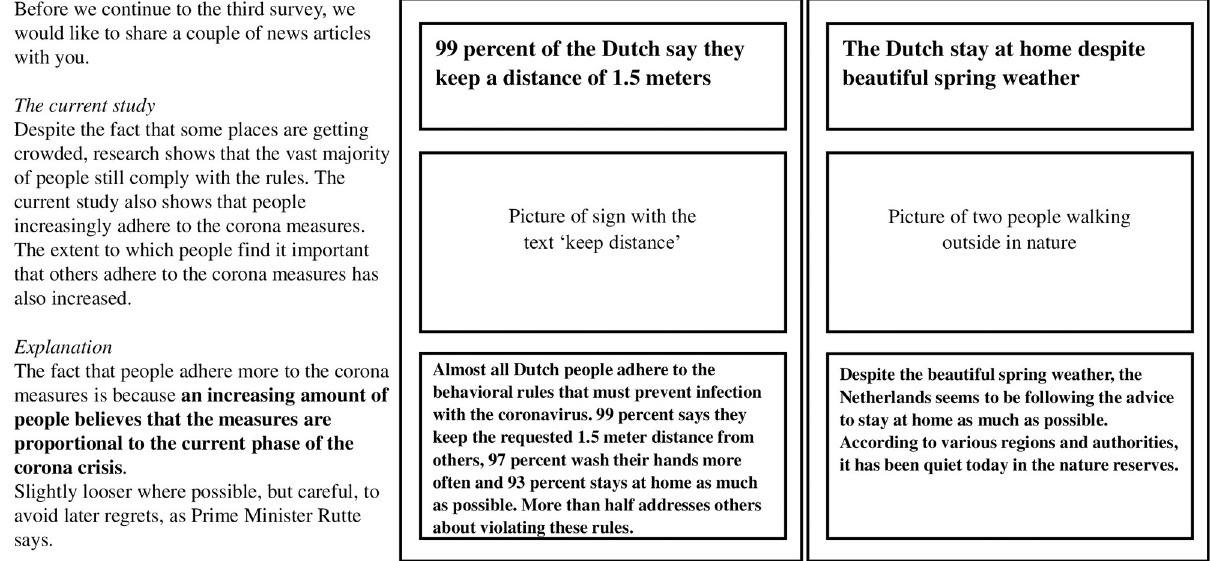
Fig 2. Example of intervention for ‘Social Norm high’ condition. News articles are replaced due to copyright. Sources of original news articles are provided in S1 File (S1.3).